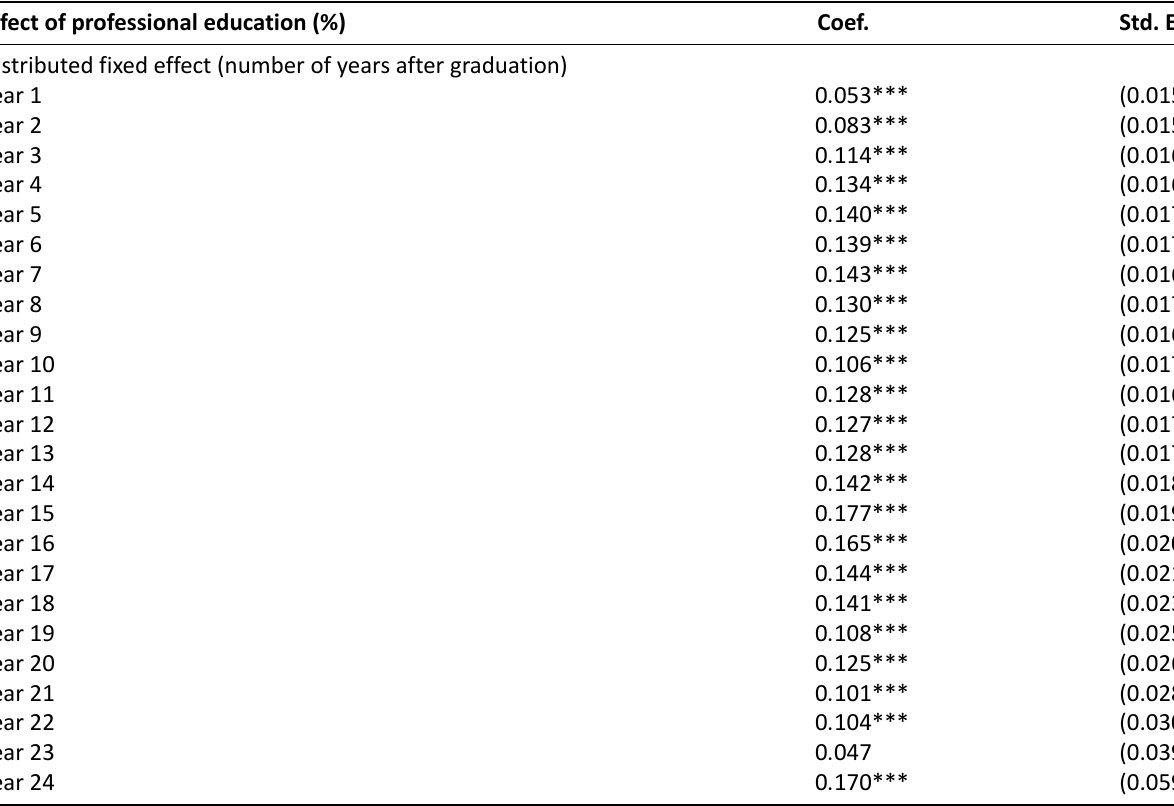
Table A2. Model I—Results of (weighted) quasi-panel fixed effects regression. Effect of professional education (%) Coef. Std.